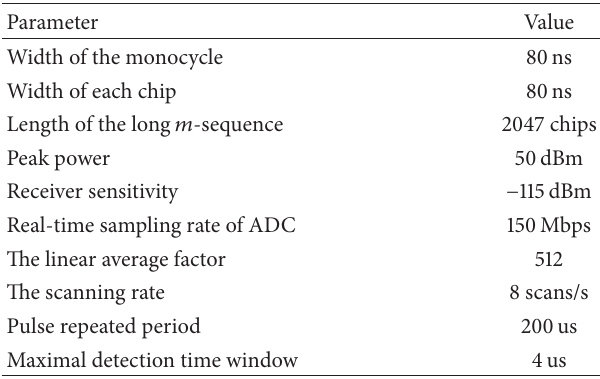
Table 1: Parameters of the low-frequency coded